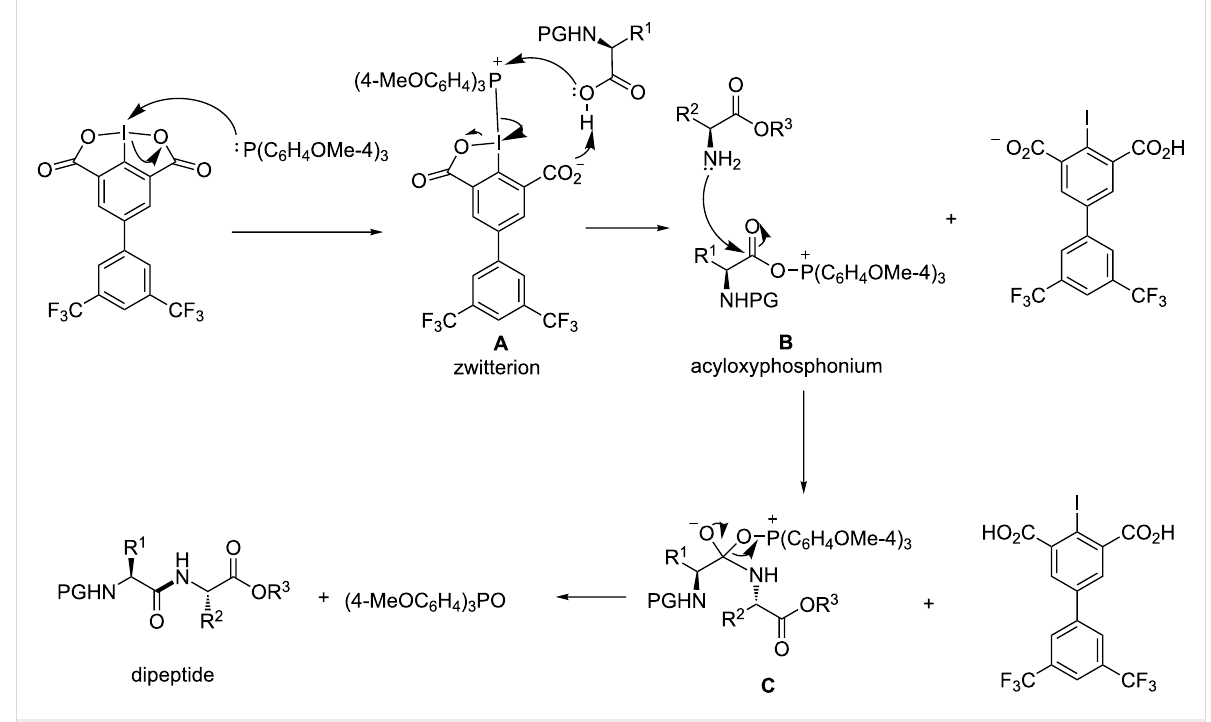
In combination with tris(4-methoxyphenyl)phosphine [(4- MeOC 6 H 4 ) 3 P], FPID can efficiently mediate peptide